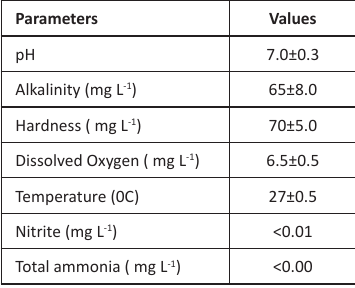
Table 1. Water Quality parameters in the experimental tanks